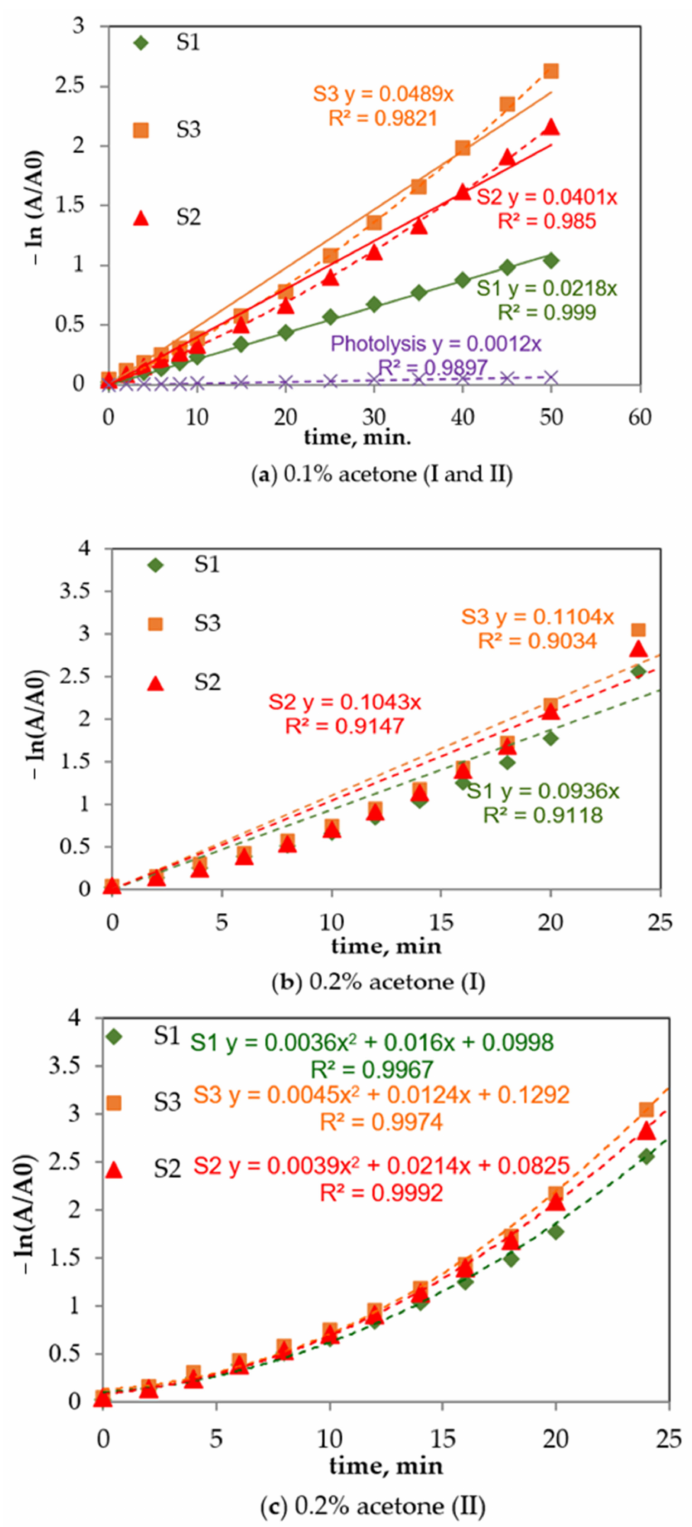
Figure 9. ( a , b ) Fits of the pseudo-first-order kinetic model for the photocatalytic MB degradation using different sensitizer concentrations and ( c ) second-order model fit for 0.2% acetone. (MB 4 ppm, room temperature, 0.3 g L − 1